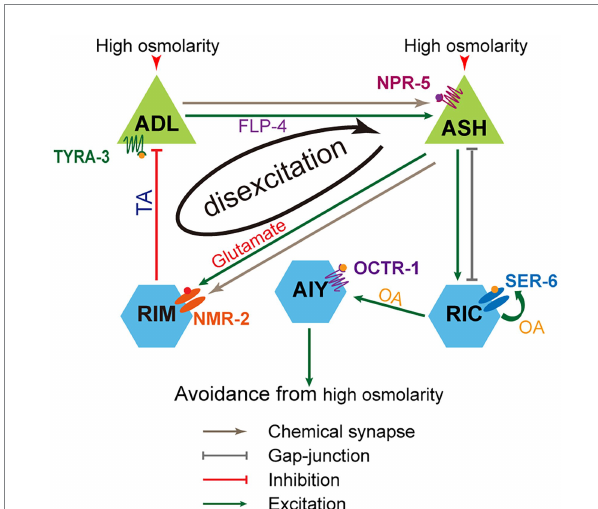
FIGURE 6 Working model for neuronal circuitry mechanism underlying the regulation of C. elegans avoidance of the mild and medium hyperosmolality. ASH and ADL interact and form a negative feedback circuit with the involvement of RIM interneurons. In the circuit, ADL promotes ASH activities via the FLP-4/NPR-5 signaling, ASH excites RIM by glutamate/NMR-2 signaling, and RIM suppresses ADL via tyramine/TYRA-3 signaling. Thus, ASH exciting RIM reduces or removes ADL exciting ASH. The neuronal information integration modality in the circuit is disexcitation. Besides, ASH elicits hyperosmotic avoidance through ASH/RIC/AIY feedforward circuit. In this circuit, octopamine/SER-6 signaling acts as an auto-